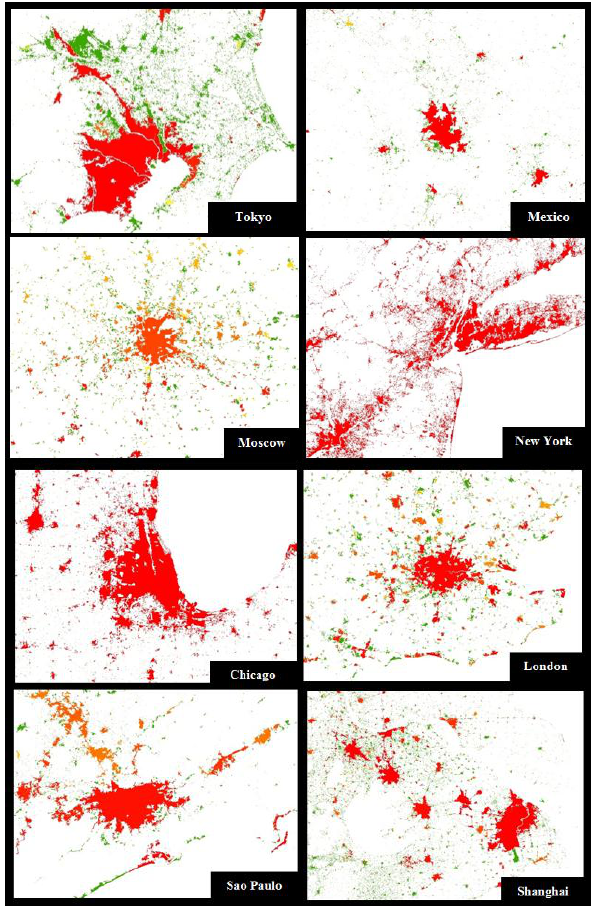
Figure 5.Central Continuum of